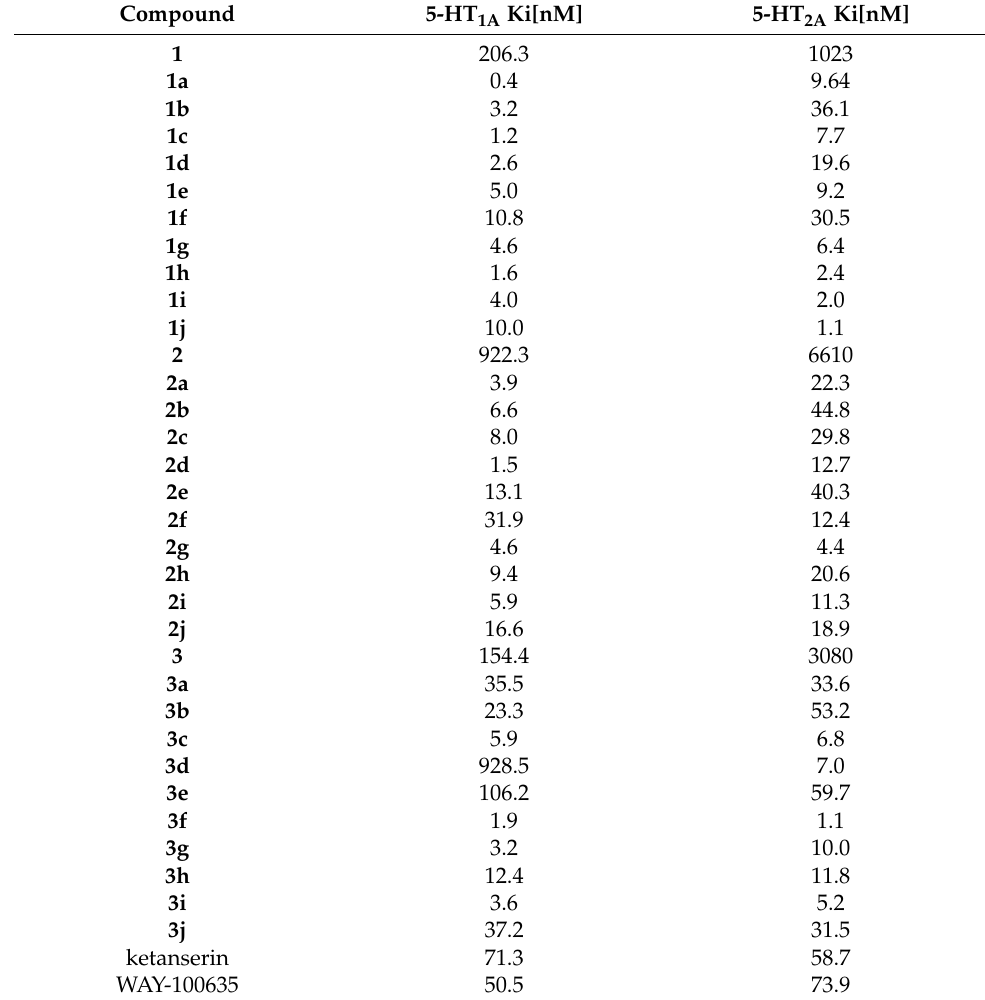
Table 1. Computational Ki values for compounds for compounds of series 1 , 2 , and 3 .